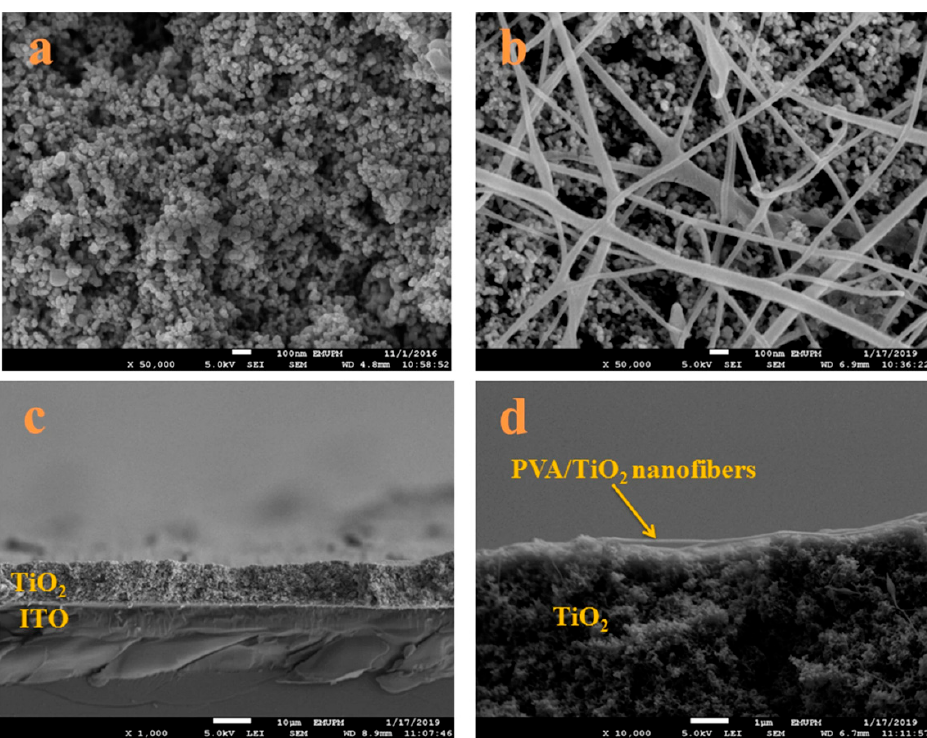
Figure 2. FESEM image of ( a ) TiO 2 nanoparticles, ( b ) TiO 2 nanoparticles with PVA/TiO 2 nanofibers, ( c ) cross-sectional view of TiO 2 nanoparticle, and ( d ) a cross-section of TiO 2 nanoparticles with PVA/TiO 2 nanofibers. Reproduced from Ref. [64].